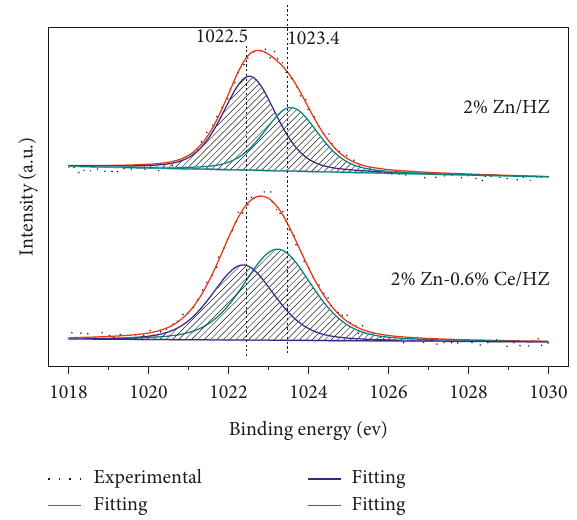
Figure 4: XPS spectra of Zn 2 p Ce/HZ.